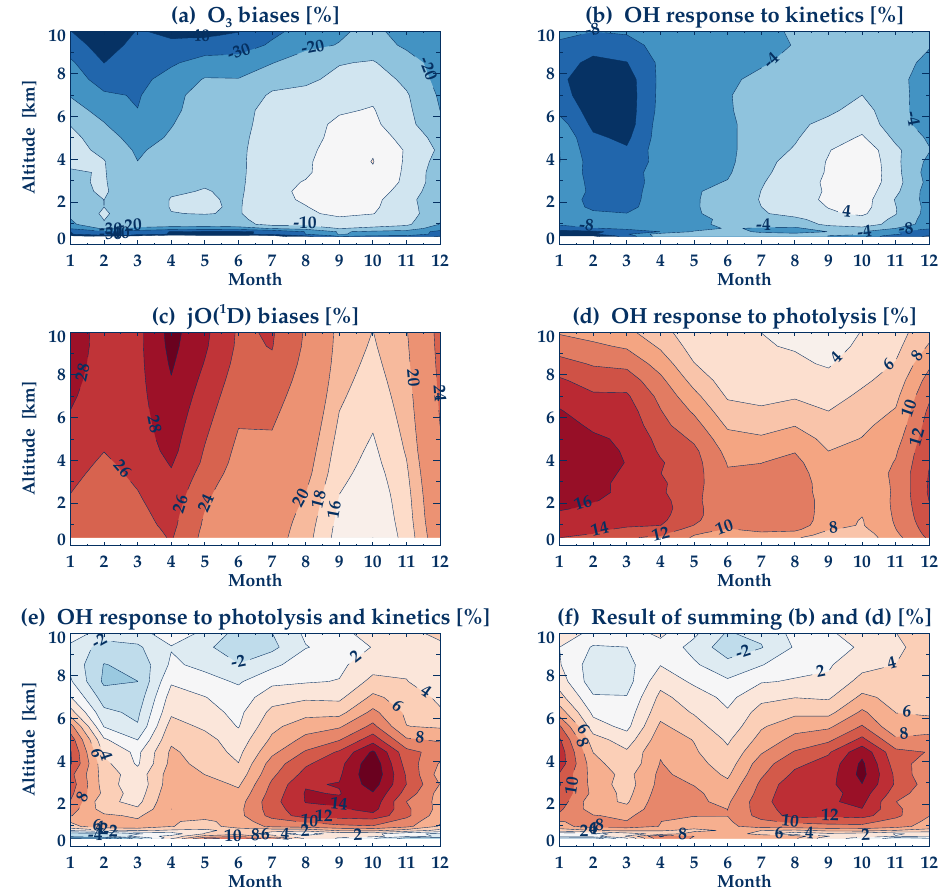
Figure 3. Multi-annual and monthly-mean OH responses to O 3 biases between observations and the reference simulation. (a) Difference in O 3 (%) between ozone sonde and NIWA–UKCA ozone, relative to NIWA–UKCA ozone as prescribed in the reference simulation. (b) OH difference (%) relative to the reference simulation accounting only for the kinetics effects of O 3 differences (e.g. with j Difference in j (%) relative to the reference simulation. (d) OH difference (%) relative to the reference simulation accounting only for O 1 D j differences (e.g. with O 3 unchanged). (e) OH differences relative to the reference simulation considering the combined kinetics and O 1 D photolysis effects. (f) Sum of (b) and (d)